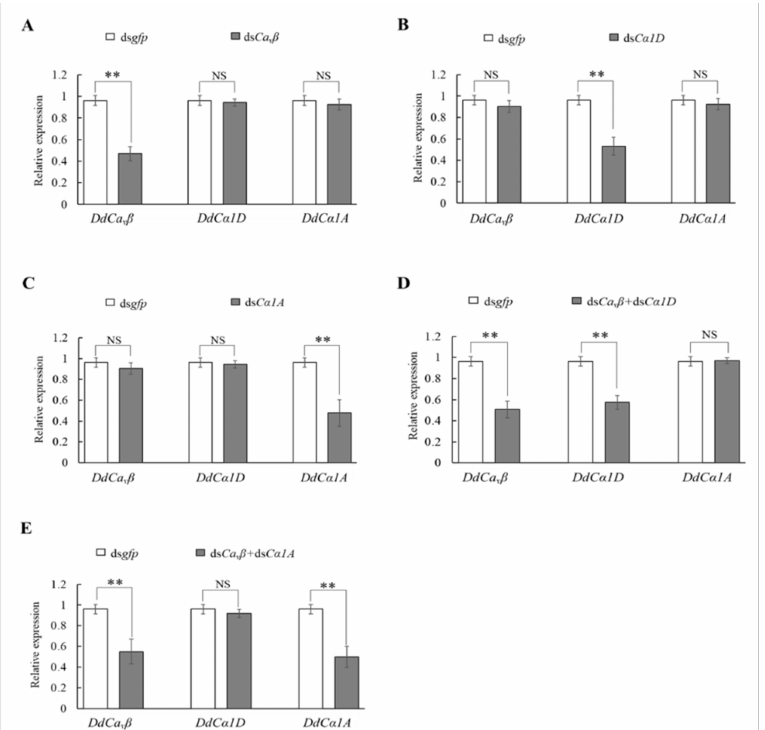
Figure 5. The relative expression levels of DdCa v β , DdC α 1D , and DdC α 1A in D. destructor after soaking with specific dsRNA. ( A ) The relative expression levels of the DdCa v β , DdC α 1D , and DdC α 1A genes after ds Ca v β treatment. ( B ) The relative expression levels of the DdCa v β , DdC α 1D , and DdC α 1A genes after d sC α 1D treatment; ( C ) The relative expression levels of the DdCa v β , DdC α 1D , and DdC α 1A genes after ds C α 1A treatment; ( D ) The relative expression levels of the DdCa v β , DdC α 1D , and DdC α 1A genes after ds C α 1D + ds Ca v β treatment; ( E ) The relative expression levels of the DdCa v β , DdC α 1D , and DdC α 1A genes after ds C α 1A + ds Ca v β treatment. Significant differences between the treatment and control are indicated with a line with asterisks (** p < 0.01; Student’s t test). “NS” indicates that there was no significant difference between the